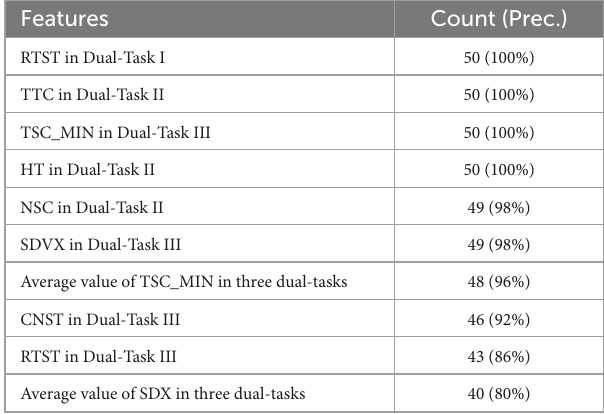
TABLE 3 The 10 most important features for evaluating processing speed. Features Count